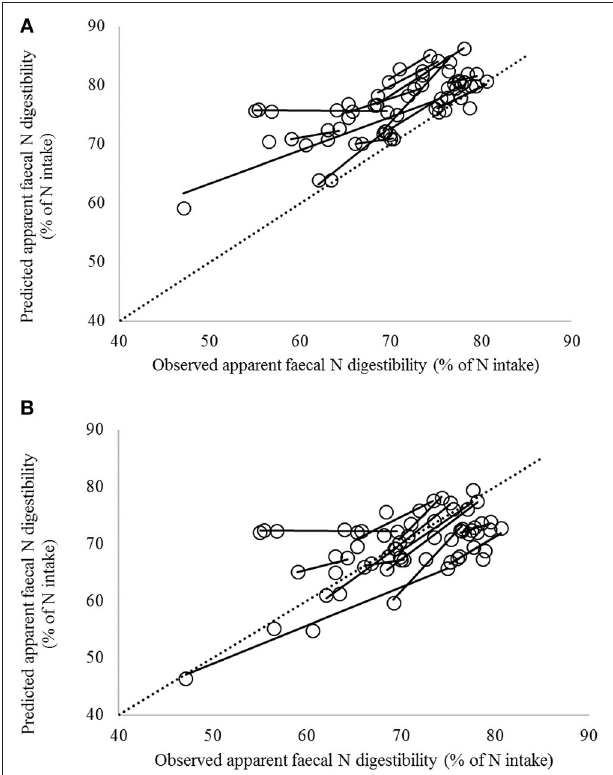
FIGURE 3 | Comparison of observed and predicted apparent fecal N digestibility values according to (A) the CVB model (the current Dutch feed evaluation system of net energy of lactation; Van Es, 1978) and (B) the Tier 3 model currently used for enteric methane emission (Bannink et al., 2011) for the dataset with observations for lactating cows in 13 Dutch trials including 62 dietary treatments. Solid lines indicate regression of predicted against observed values within trial; the dashed line indicates the line of